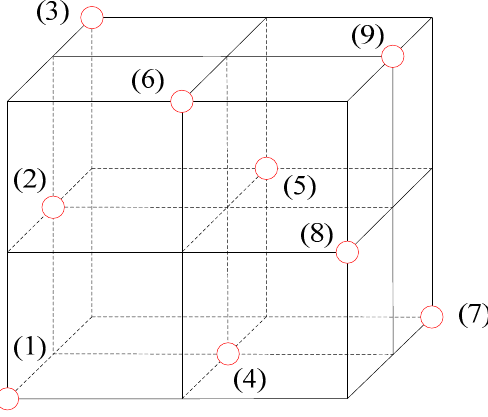
Figure 2. Uniform distribution of the orthogonal test.